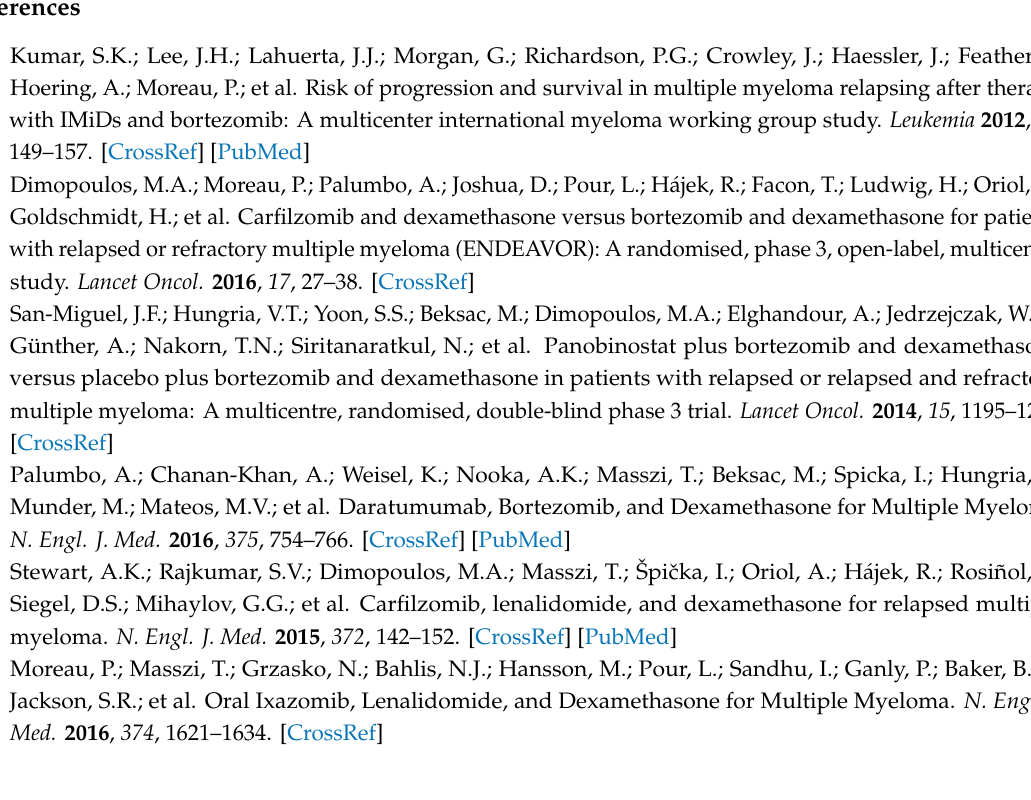
Table S1: Comparison of patients’ characteristics treated or not with lenalidomide before treatment with KRd in real life, Table S2: Comparison of patients’ characteristics treated or not with pomalidomide before treatment with KRd in real life, Table S3: Univariate and multivariate analysis of PFS and OS in 21 patients who received at least 18 cycles of